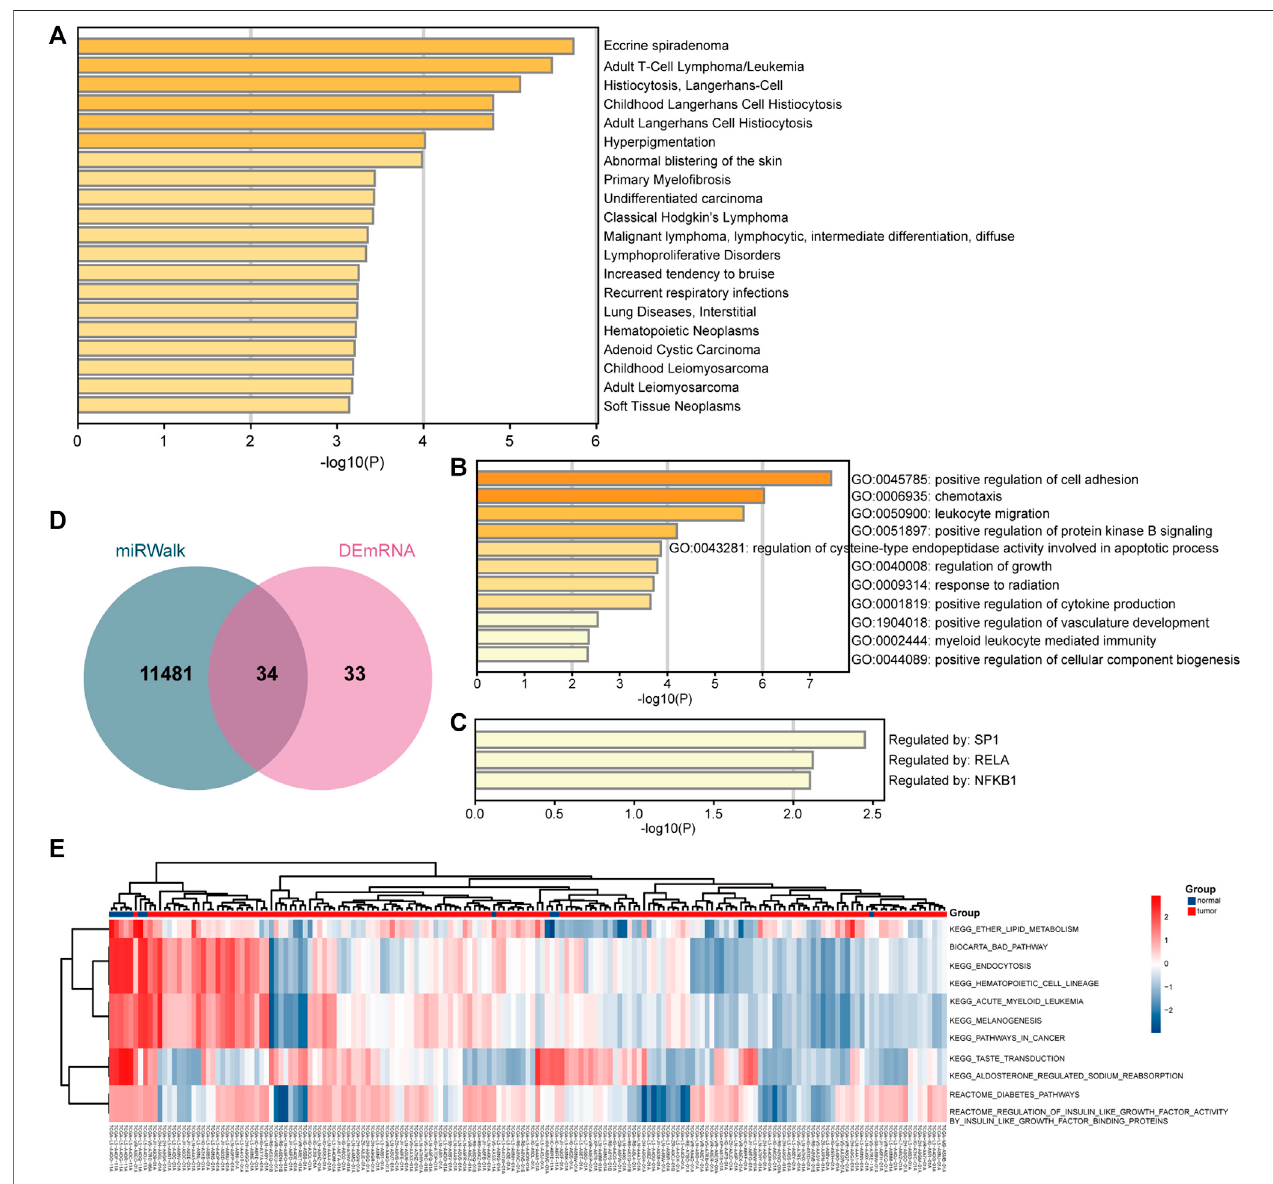
FIGURE 4 | Biological enrichment analyses of target mRNAs. (A) Enrichment results based on the DisGeNET database. (B) Enrichmentresults based on the gene ontology (GO) and biological process (BP) databases. (C) Enrichment results based on the TRRUST database. (D) Comparison of target mRNAs predicted by miRNAs and differentially expressed mRNAs. (E) GSVA analysis of key